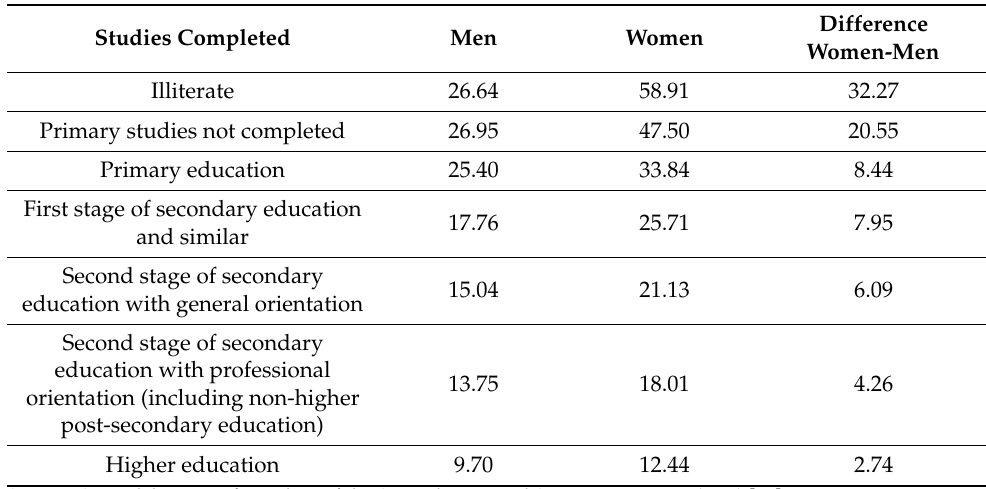
Table 4. Unemployment rate by level of study and sex, in percentage